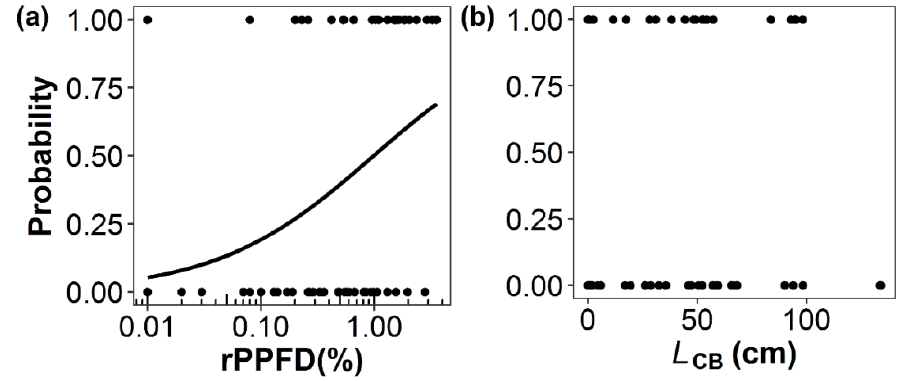
Figure 1. Effects of ( a ) relative photosynthetic photon flux density (rPPFD); and ( b ) the length between its basal location and the crown base ( L CB ) on the probability ( P ) that one or more current-year shoots